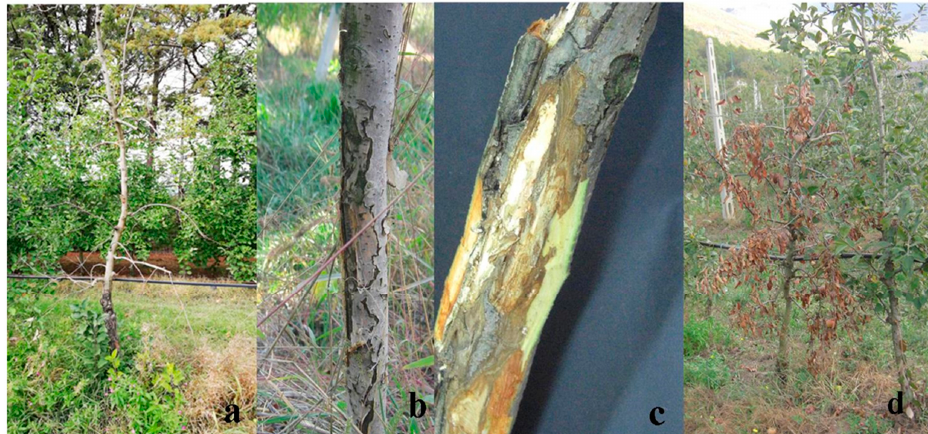
Figure 6. Apple trees located in the Val d’Agri area showing die-back symptoms ( a – c ) and death of tree caused by die-back (d). Figure a—courtesy of Dr. Camilla Nigro, ALSIA, Basilicata Region.